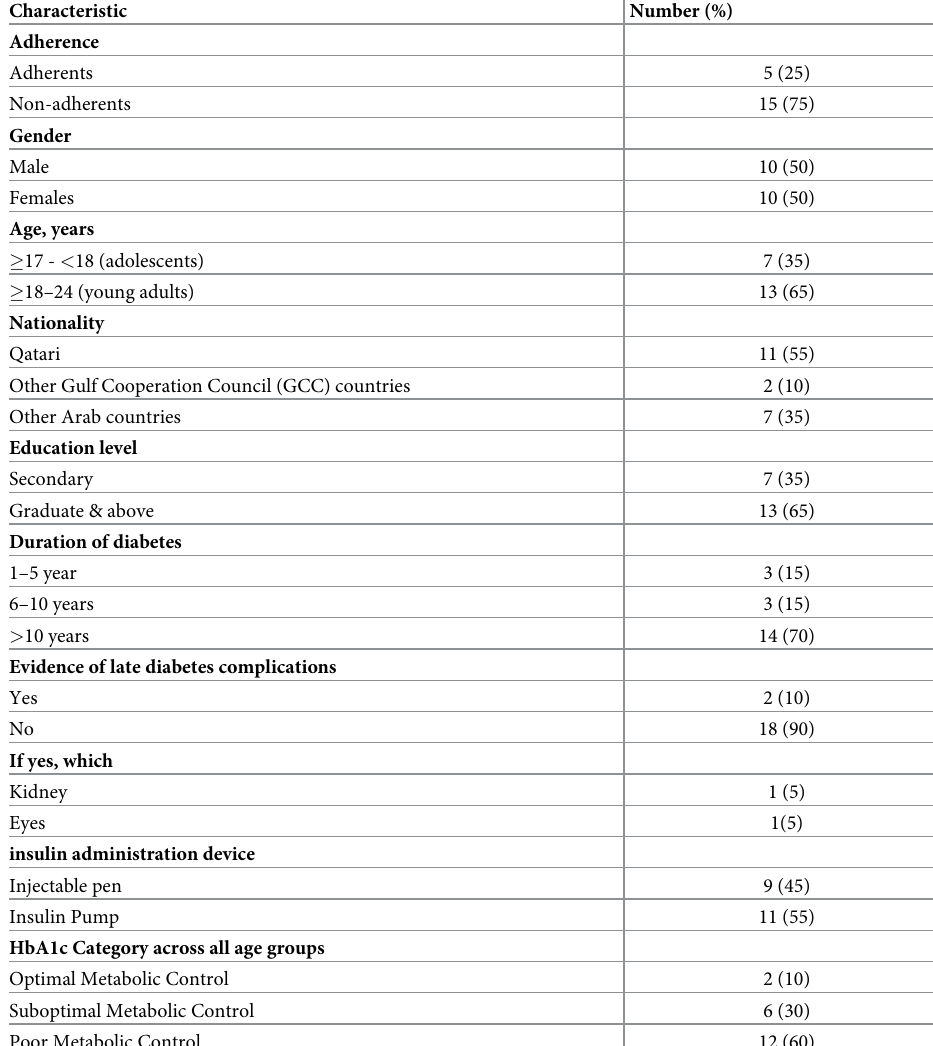
Table 2. Main characteristics of the sample (n =